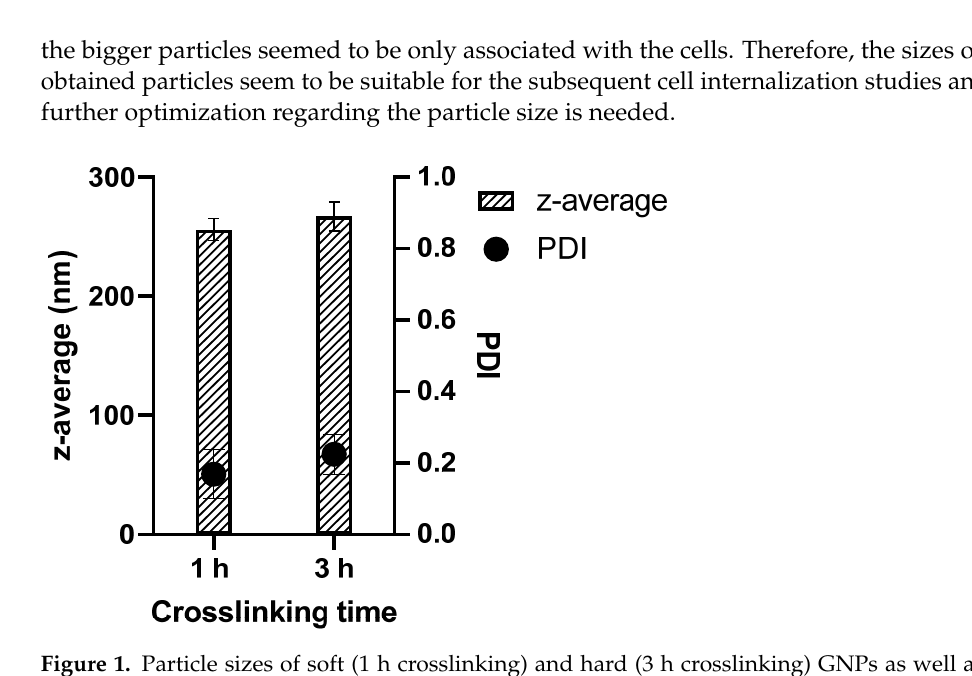
Figure 3. Young’s moduli for 150 kDa FITC-dextran-loaded GNPs produced with the two different crosslinking times applied in this study. Data is presented as the mean ± SD of three independently prepared batches, **** 3 h crosslinked particles are significantly different from 1 h crosslinked GNPs ( p < 0.001). 3.3. Cell Viability To detect a possible cell viability reducing effect and to exclude an influence from the particle elasticity on the cell viability, particles were tested on dTHP-1 and RAW 264.7 macrophages. The viability of dTHP-1 and RAW 264.7 cells after incubation of GNPs for 24 h was tested in terms of their mitochondrial activity by MTT assay (Figure 4). The cell viability in each group was above 90% relative to the controls for all tested concentrations of GNPs ranging from 5 to 1000 μ g/mL, demonstrating that GNPs were nontoxic even at high concentrations. This indicates that the modified preparation procedure is not leading to any critical residues or changes. Furthermore, an elasticity dependent negative effect of GNPs on the metabolic activity of the tested macrophage cell lines can be excluded.